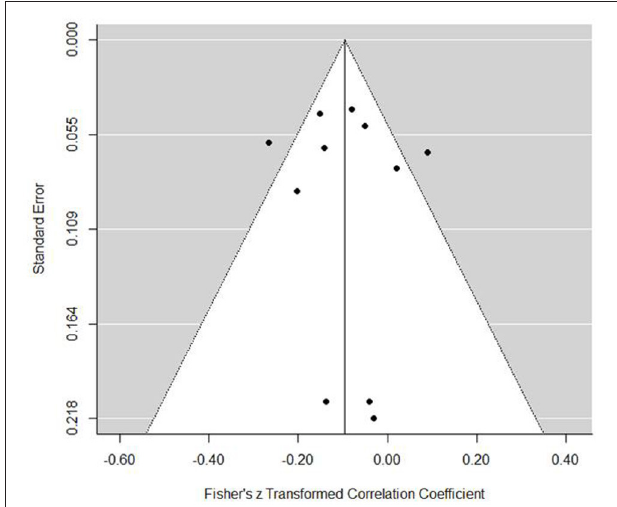
FIGURE 7 | Goal withdrawal coping forest plot. (Haney and Long, 1995; Gaudreau et al., 2002; Amiot et al., 2004; Gaudreau and Antl, 2008; Gaudreau